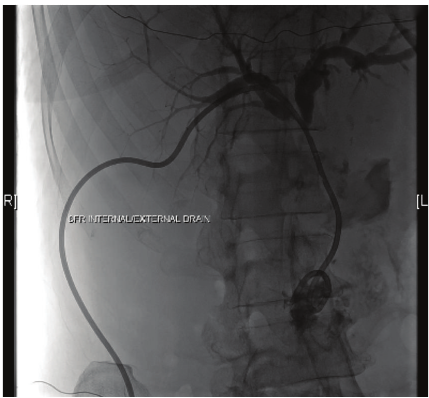
Figure 3: Case 1—percutaneous trans-hepatic cholangiography (PTC) with 8-French internal and external biliary drains.